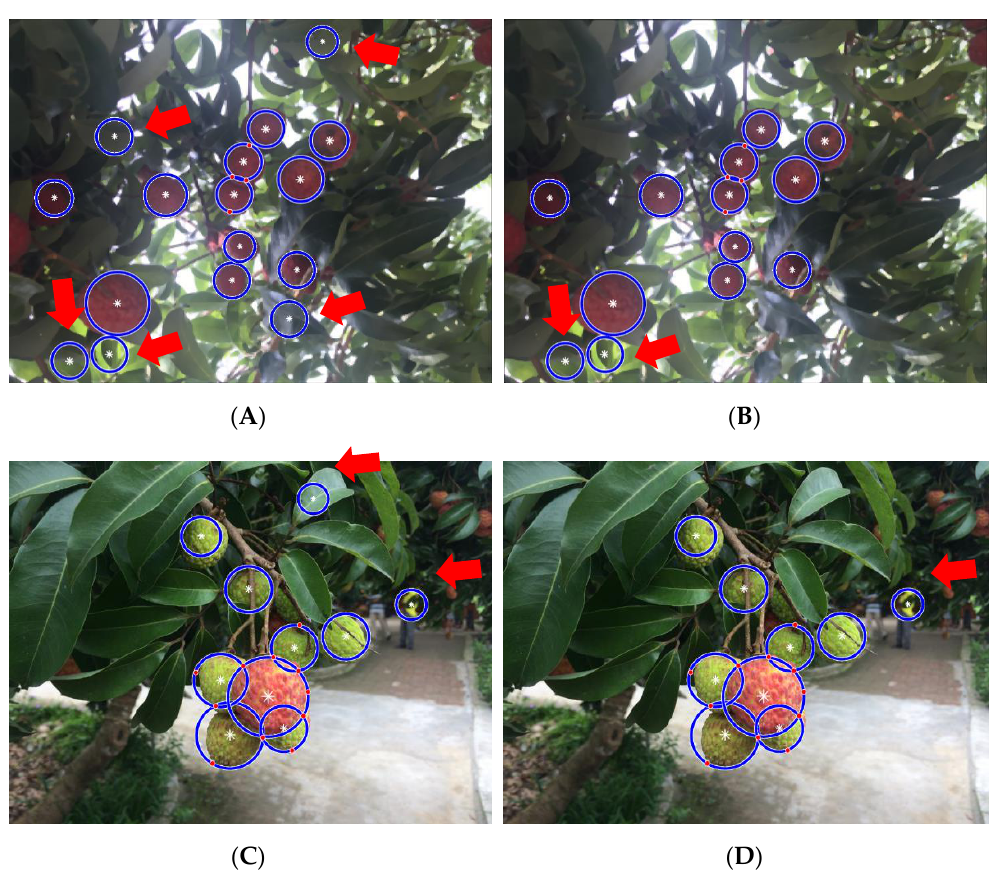
Figure 13. Lychee fruit recognition results in orchard environments using the LBP-SVM classifier. ( A,C ) Results without using the LBP-SVM classifier. ( B,D ) Results using the LBP-SVM classifier.